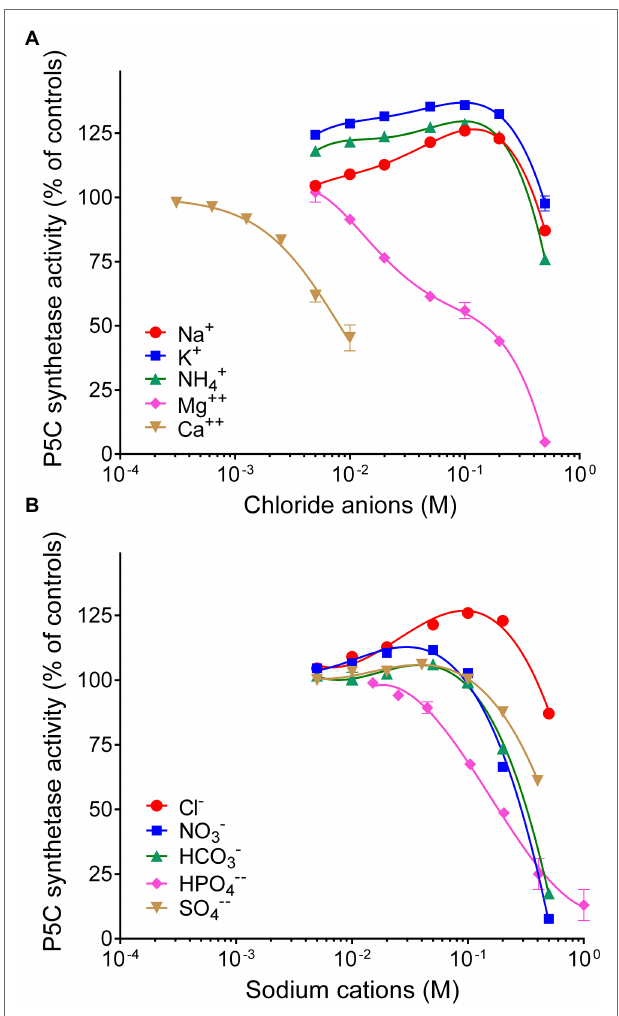
FIGURE 5 | Effect of anions and cations on the activity of rice P5C synthetase 2. The steady state rate of the enzyme was measured in the presence or in the absence of increasing concentrations of chlorides of various cations (A) or the sodium salts of various anions (B) , ranging from 0.3 mM to 1 M. To minimize ion presence in the assay mixture, in the former case, Tris-HCl buffer was replaced with 10 mM potassium phosphate buffer, pH 7.5, whereas in the latter case, its concentration was lowered to 10 mM. The actual pH in each sample was measured with a microelectrode at the end of the incubation, to ensure that the addition of salts did not cause a pH change in the reaction mixture. Activity was expressed as per cent of mean value in untreated controls. Data are means ± SE over three technical replicates. The experiments were repeated three times with different enzyme preparations, and almost identical patterns were obtained. To calculate the concentration of Mg ++ ions able to inhibit activity by 50%, data were expressed with respect to parallel samples containing equimolar amounts of NaCl, to compensate the stimulatory effect of chlorides in the range 10– 200